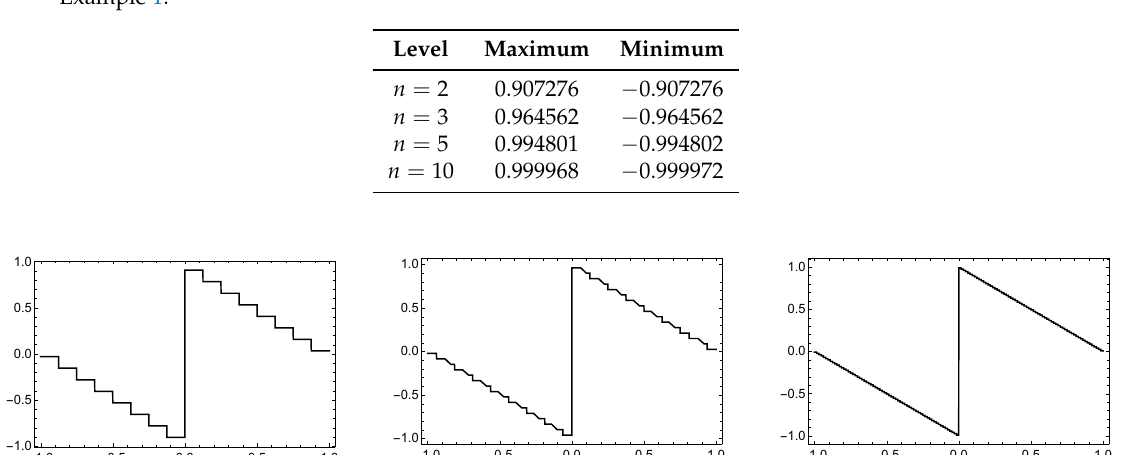
Table 1. Approximate maximum overshoot and undershoot in neighborhoods of x = 0 using Q n f of Example 1.